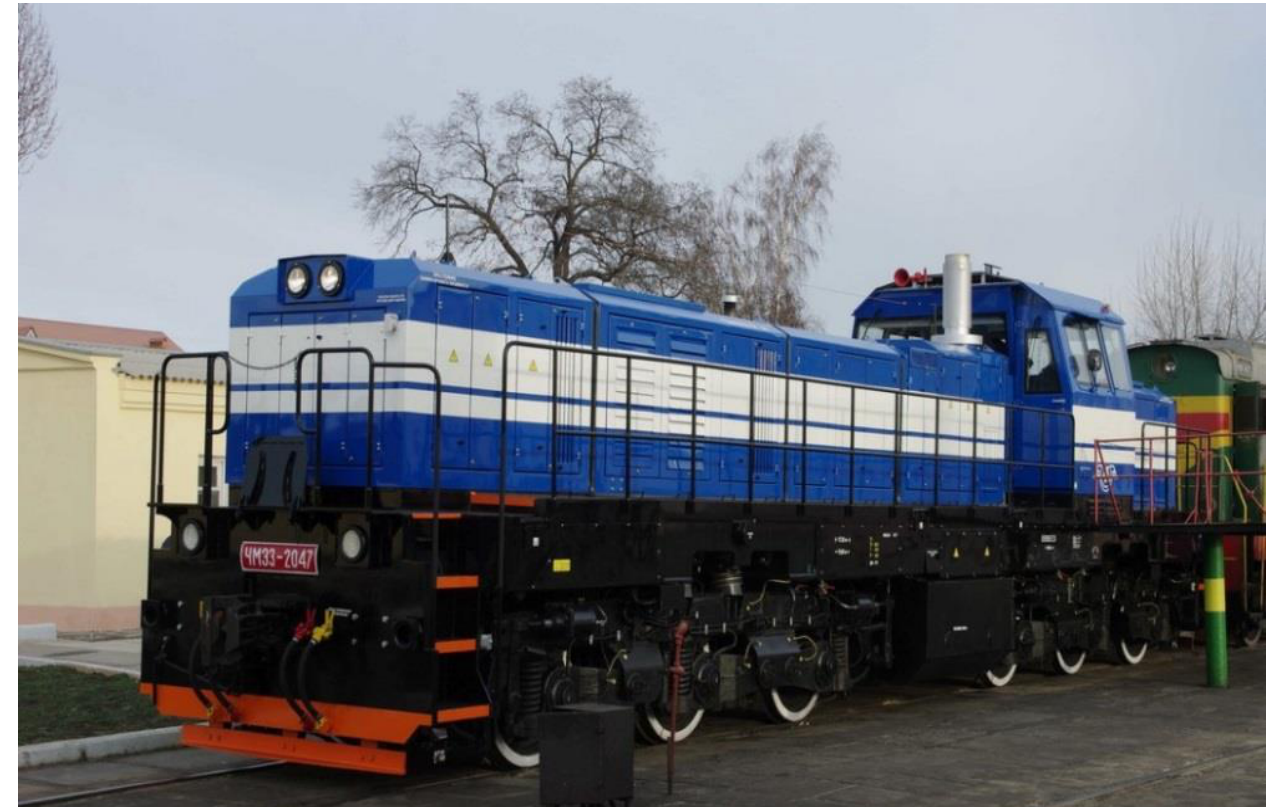
Figure 2. Modernized ChME3 locomotive at the JSC “Ukrzaliznytsia” regional branch of “Odessa Railway”. Source: own work.